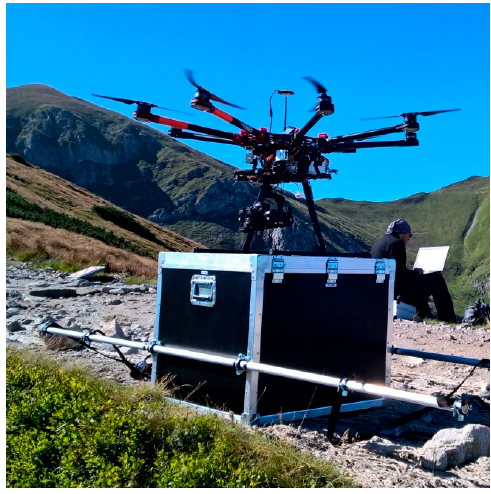
Figure 3. The device used for measurements, the DJI S1000 multicopter (source: authors’ own study). Field surveys with the UAV were preceded by drawing up UAV flight plans for each hiking trail